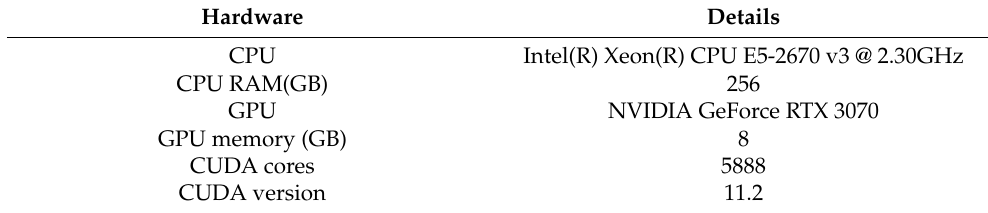
Table 2. Hardware environment setups employed in this paper.